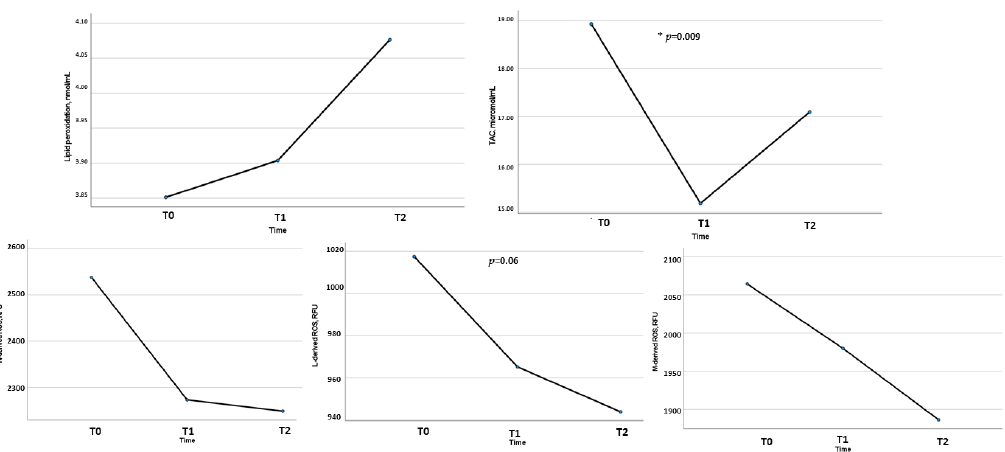
Figure 6. Changes in Oxidative Stress Parameters from T0 to T2 ( n = 16). N indicates neutrophil; L, lymphocyte; M, monocyte; RFU, relative fluorescence unit; ROS, reactive oxygen species; TAC, total antioxidant capacity. * p <0.05